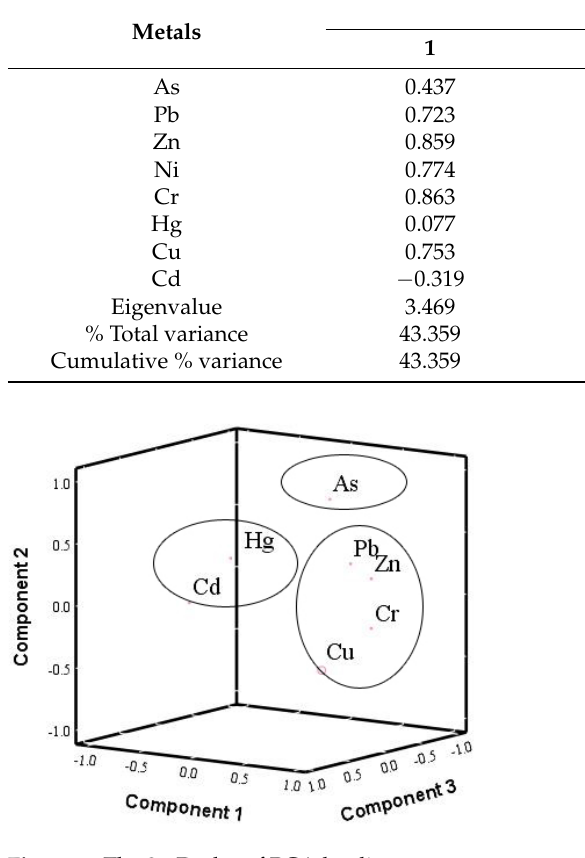
Figure 6. The 3 − D plot of PCA loadings.